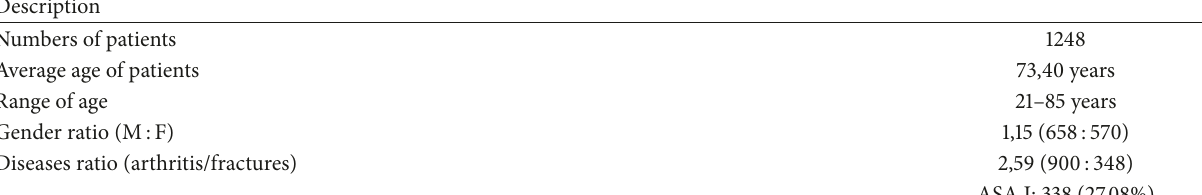
Table 1: Description of population.